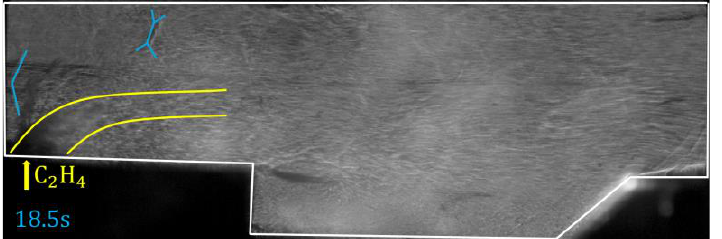
Figure 12. Shadowgraph at Case 13 (1.7D 0 I0.169), Blue is the shock train and yellow is the jet core boundary